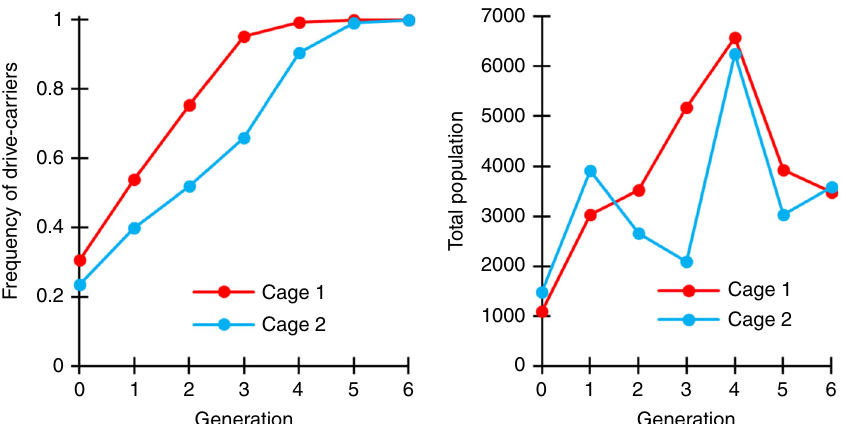
Fig. 6 Cage frequency trajectories and population sizes. In large cages, individuals homozygous for the drive allele and the Cas9 allele were mixed with individuals homozygous only for the Cas9 allele. Cage populations were maintained for several discrete generations, and all individuals from each generation were phenotyped for dsRed, indicating that they carried one or two copies of the